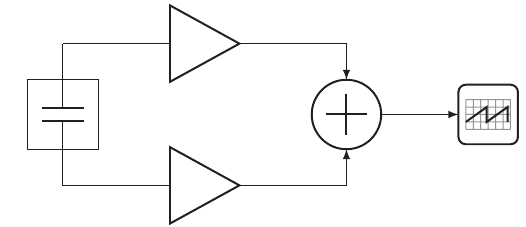
FIG. 4. Schematic model of the BPM data acquisition